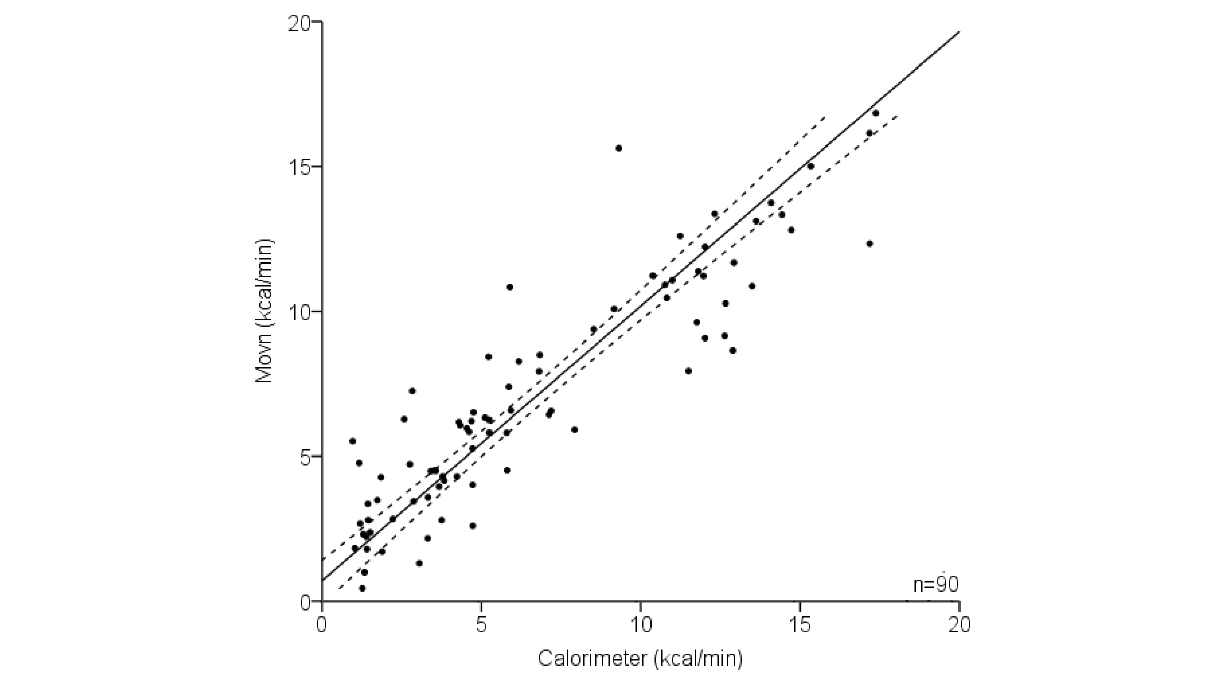
Figure 1. Relationship between measured energy expenditure (EE; indirect calorimetry) and Movn app EE derived from multivariate regression of Movn activity counts on measured EE during phase 1 laboratory-based